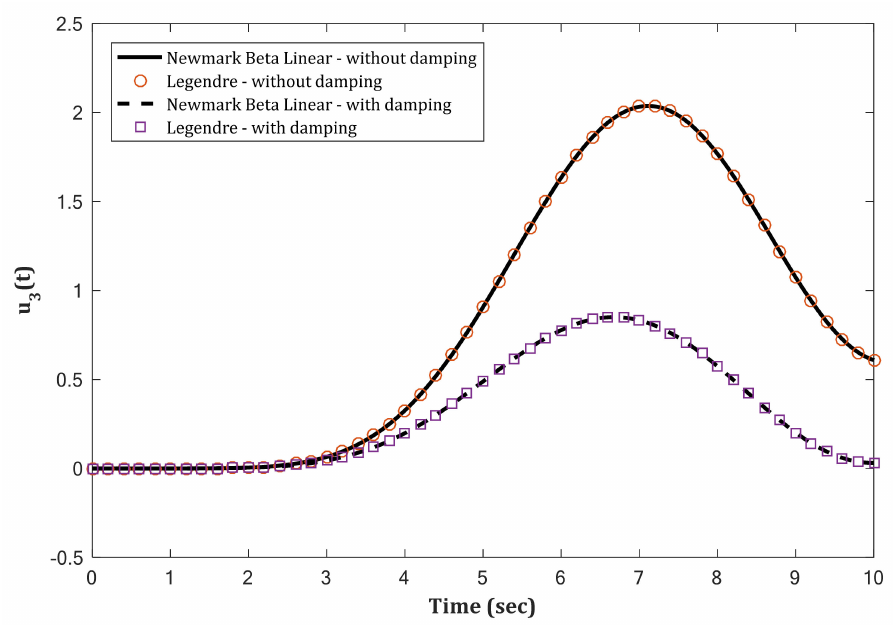
Figure 12. Forced vibration analysis of a 3DOF system. Comparison of u 3 ( t ) as function of time, as obtained using the LGM method or the linear Newmark- β